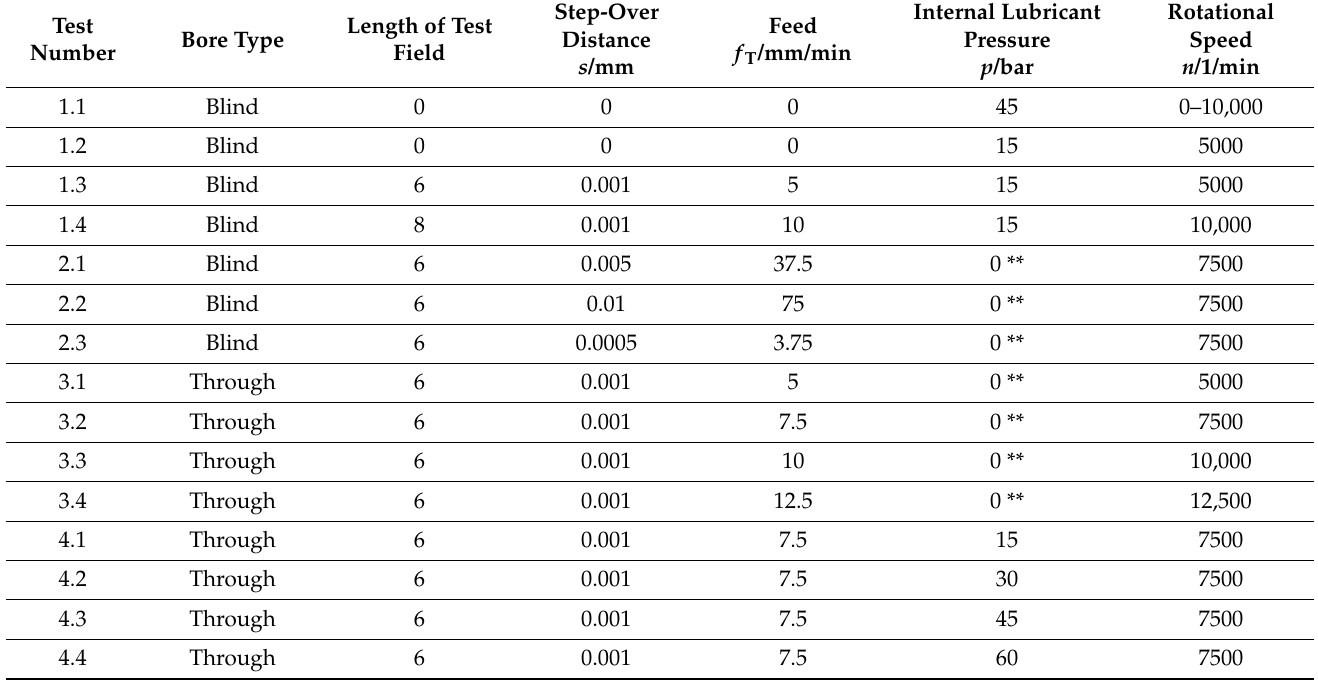
Table 2. Experimental